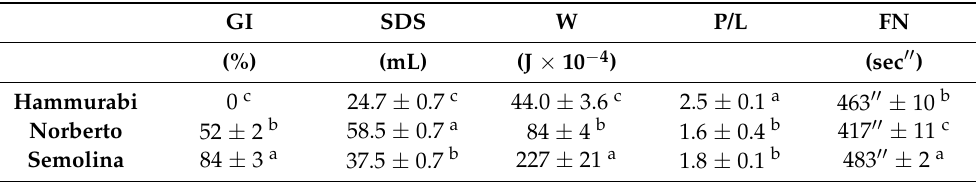
Table 2. Rheological and technological parameters of einkorn cv Hammurabi and cv Norberto wholewheat flours and durum wheat semolina. GI SDS W P/L FN (%)